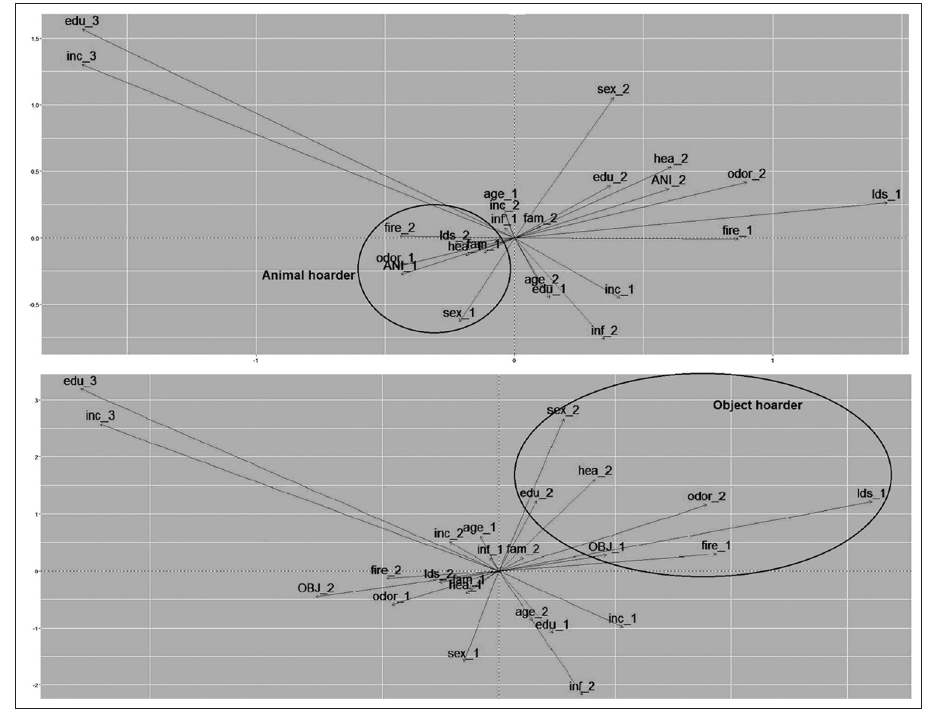
Figure-2: Multiple correspondence analysis between animal and object hoarding cases in Curitiba, Brazil, from 2013 to 2015. (ANI_1) Animal hoarding; (ANI_2) No animal hoarding; (OBJ_1) Object hoarding; (OBJ_2) No object hoarding; (sex_1) Woman; (sex_2) Men; (inc_1) Income less or equal than 1 MW; (inc_2) Income between 1 and 3 MW; (inc_3) Income more than 3 MW; (edu_1) Until middle school; (edu_2) High school; (edu_3) College; (hea_1) With health problem; (hea_2) No health problem; (fam_1) Family assistance; (fam_2) No family assistance; (odor_1) Unpleasant odor; (odor_2) No unpleasant odor; (fire_1) Fire risk; (fire_2) No fire risk; (lds_1) Landslip risk; (lds_2) No landslip risk; (inf_1) Risk of vectors proliferation; (inf_2) No risk of vectors